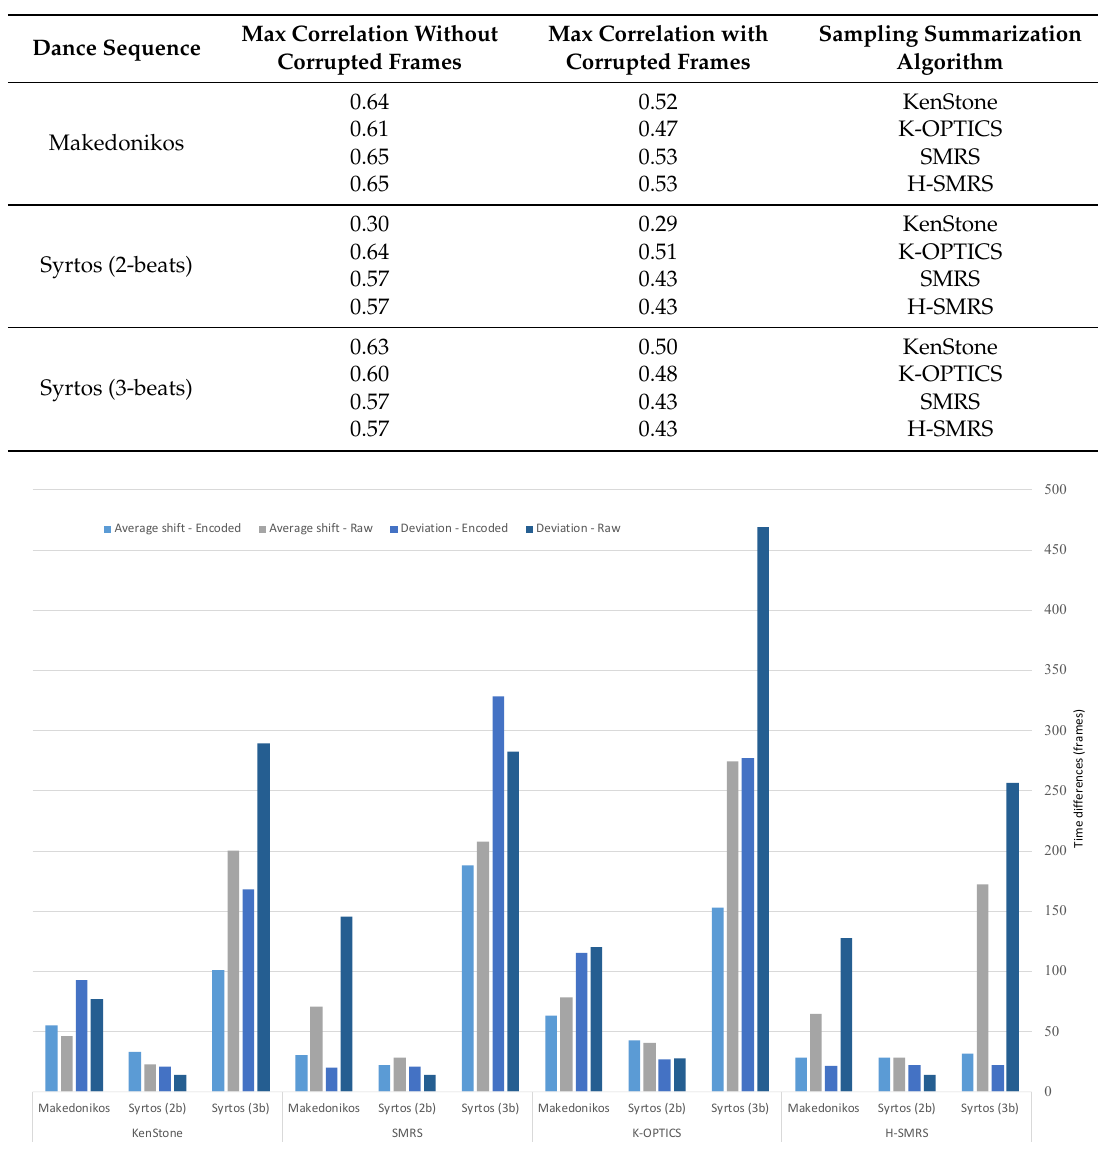
Figure 10. Data input type summarization impact when two dancers performed simultaneously for all the examined dance